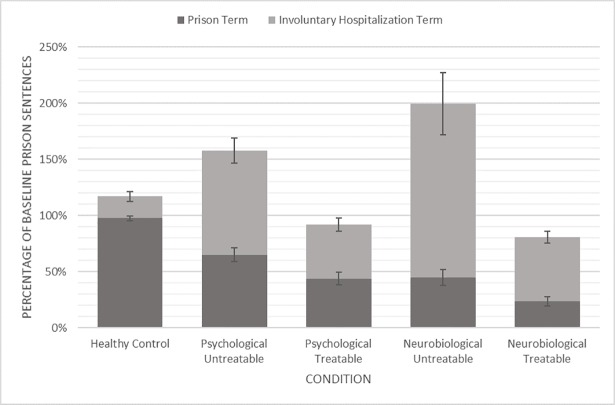
Punishment change score by condition.Bars denote the percentage change in time from individual baseline punishment rating across conditions, for their revised prison recommendation (dark grey) and recommendation for involuntary hospitalization (light grey). Statistically significant differences mirror the patterns described in H1-H4. Standard error bars shown.